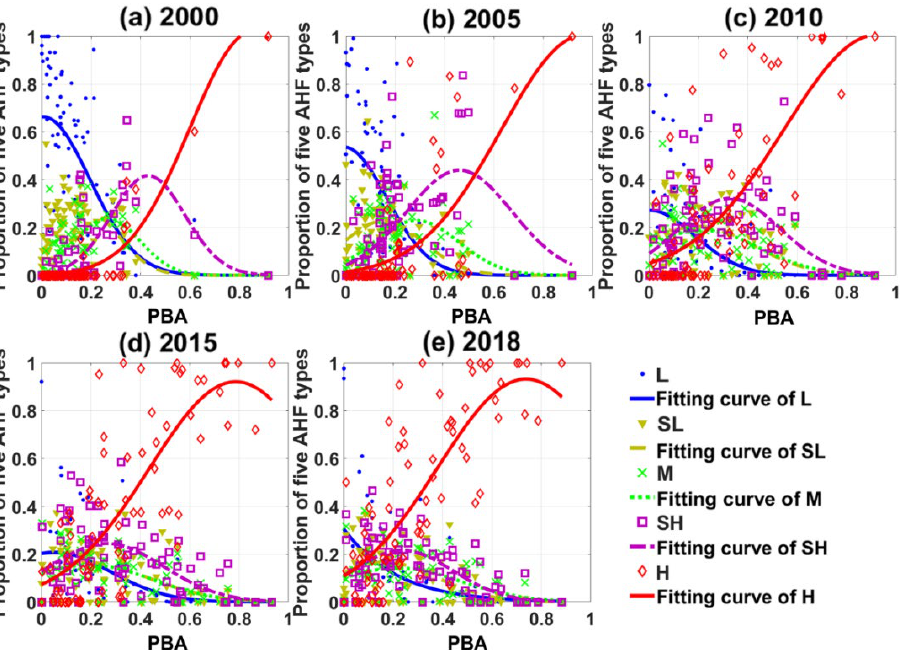
Figure 5. Scatter diagrams and graphs of the relationship between different levels of AHF and the PBA in a 5 km radius buffer zone around the meteorological stations in different years: ( a ) 2000, ( b ) 2005, ( c ) 2010, ( d ) 2015 and ( e ) 2018.